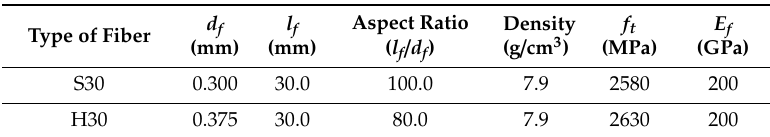
Table 3. Properties of steel